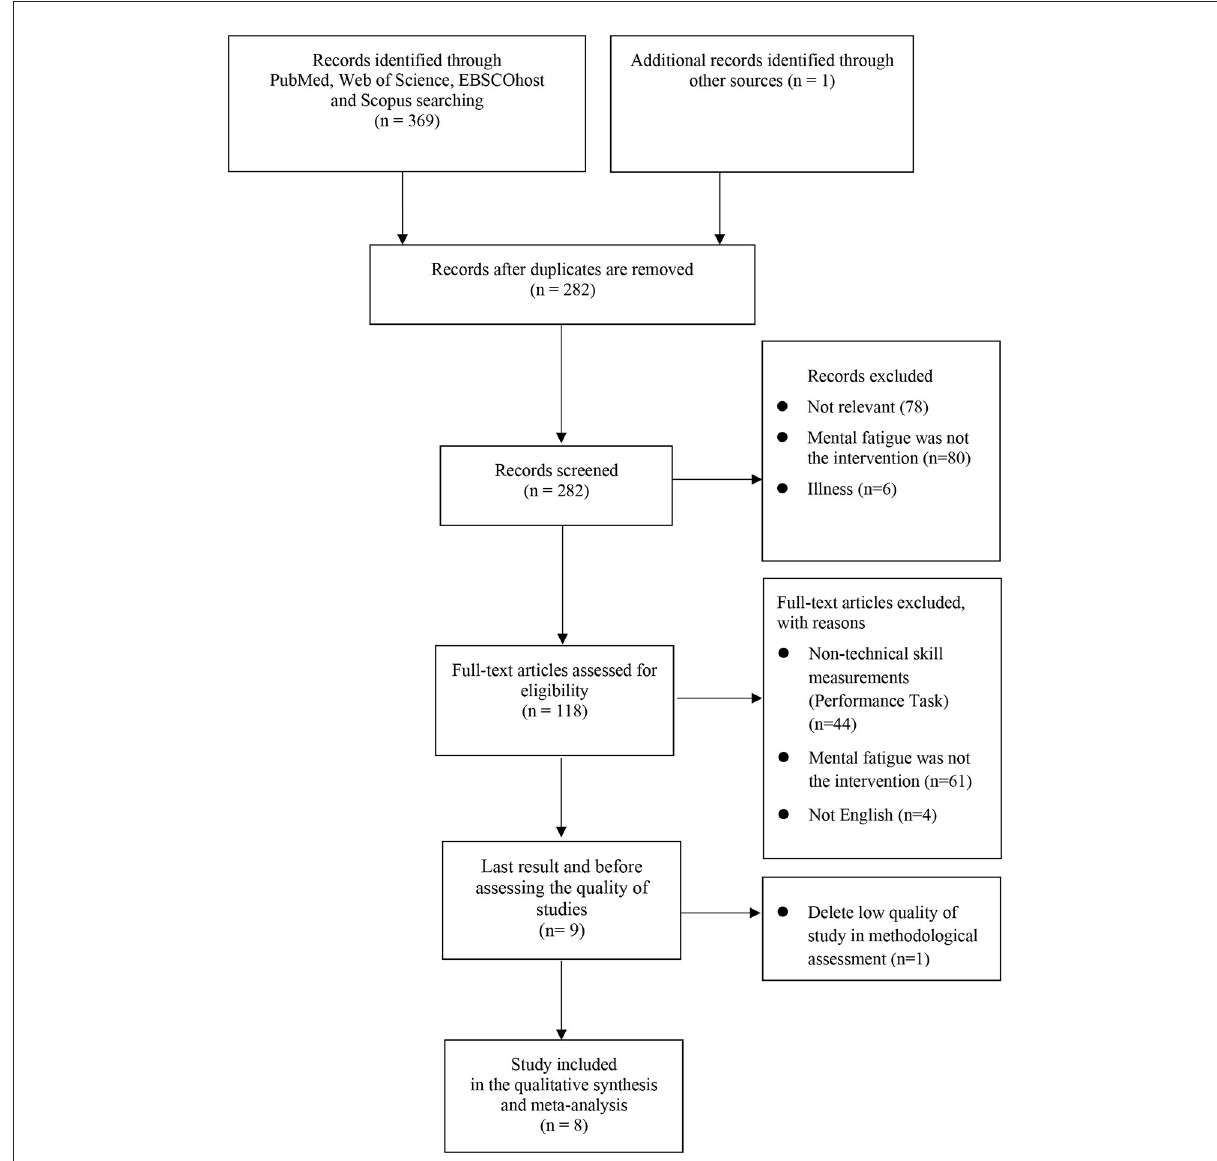
FIGURE1 PRISMA selection process